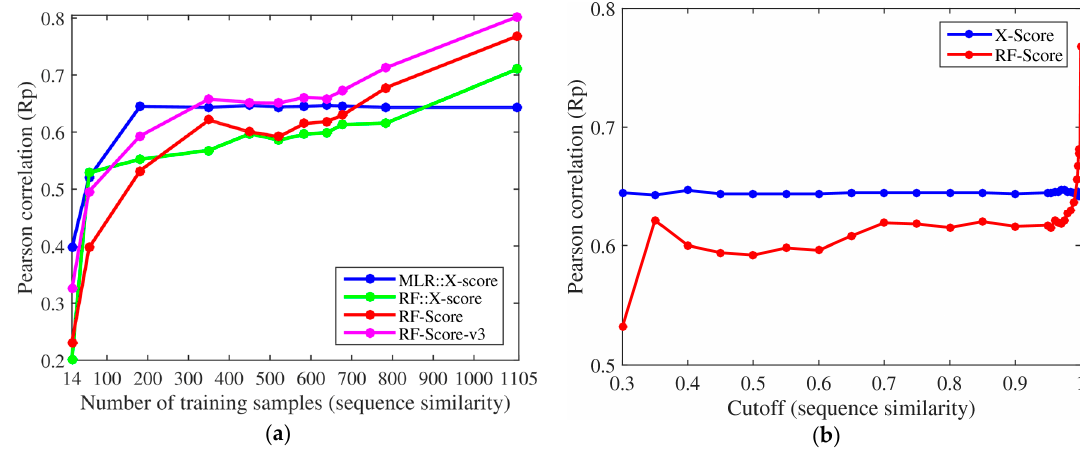
Figure 2. Test set performance of SFs trained with nested data sets at different protein sequence similarity cutoffs. ( a ) Instead of protein structural similarity (Figure 1), sequence similarity cutoffs were here employed to build 11 nested training sets, including two training sets smaller than those previously used in [9]. In addition, we also included in the comparison two additional machine-learning SFs (RF::X-Score and RF-Score-v3). Each of the four SFs was trained with these nested data sets, leading to 11 implementations of each SF. Each of the resulting 44 SF implementations was tested against the same 195 diverse protein–ligand complexes in the test set. Analogous conclusions were reached in this case. X-Score cannot benefit from more than 181 training samples, whereas its RF variant (denoted as RF::X-Score) and both RF-Score and RF-Score-v3 keep learning and increasing the correlation of their predicted binding affinities to the experimentally measured values and ultimately surpassed X-Score. ( b ) This plot reproduces the relevant part of the graphical abstract of Li and Yang’s paper. Note that, to label one training set complex as similar, it was enough that a single test set complex had an above-cutoff similarity to the training complex. Because the test set was generated by picking three representatives of each of the 65 sequence-based clusters, the vast majority of the remaining test complexes would tend to contain a dissimilar protein to that of the similar training complex.